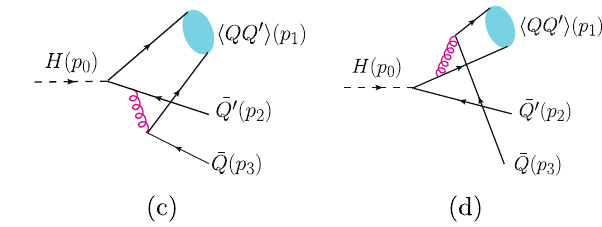
] (cid:3) bc (cid:5)[ 1 P ] ¯ (cid:3) cc (cid:5)[ 3 P , (cid:3) bc (cid:5)[ 3 P J ] ¯ , (cid:3) bb (cid:5)[ 1 P 1 ] ¯ and (cid:3) bb (cid:5)[ 3 P J ] 6 J 6 , 1 3 / 6 3 / 6 3 , 3